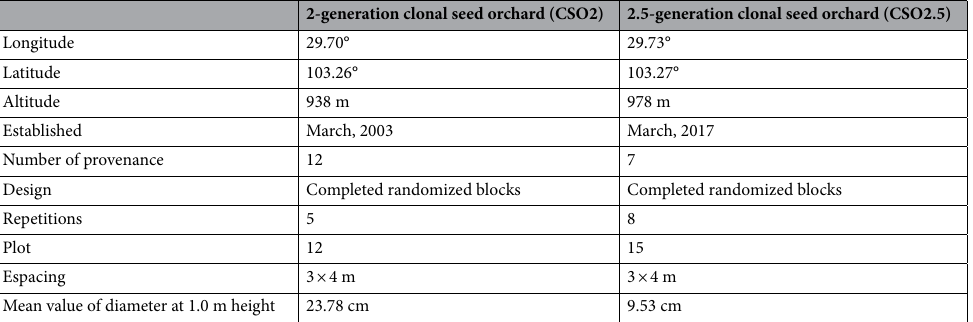
Table 5. Characteristics of the seed